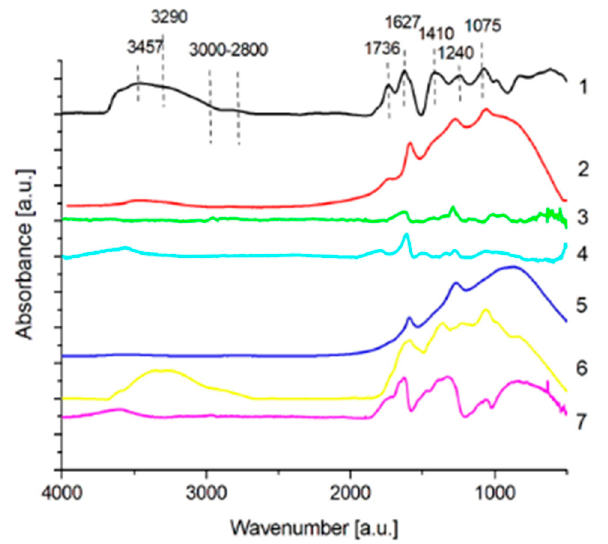
Figure 3. FTIR spectra of unmodified GO and GO reduced with various reducing agents.